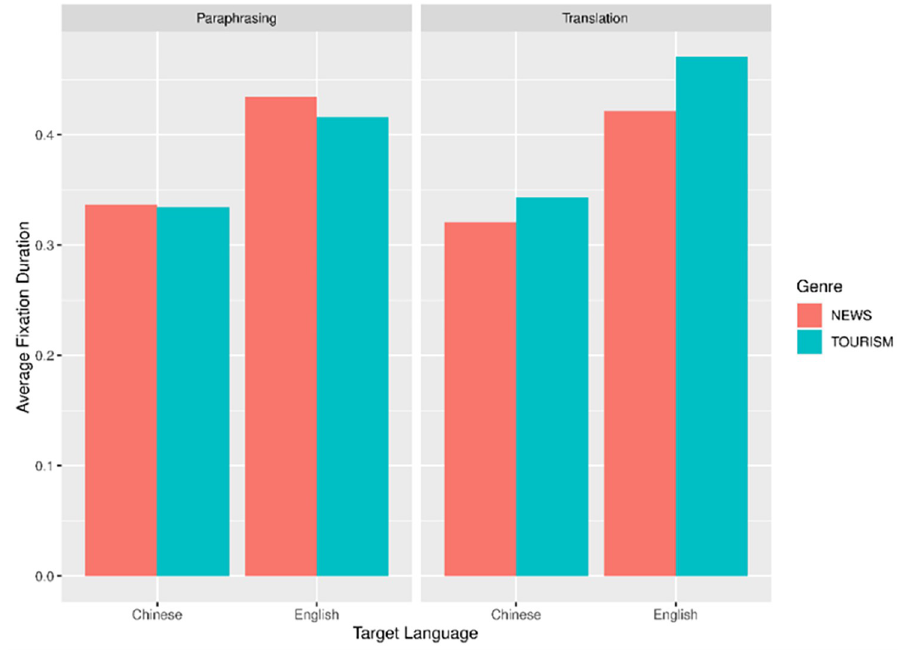
Fig 3. Average fixation duration in